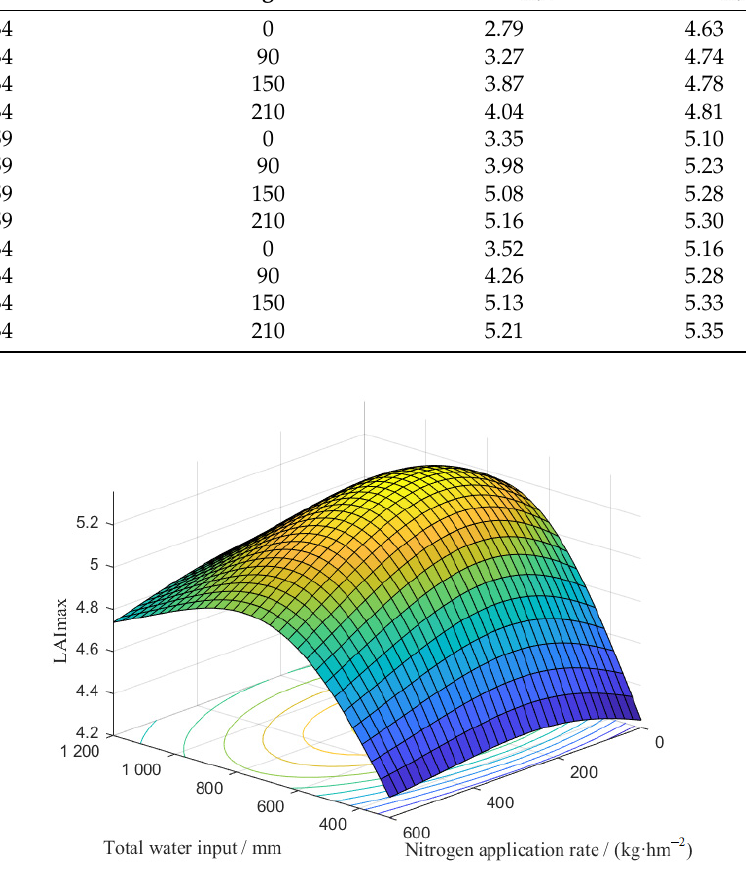
Figure 3. LAI max prediction results with Gauss regression model under water and nitrogen cou-